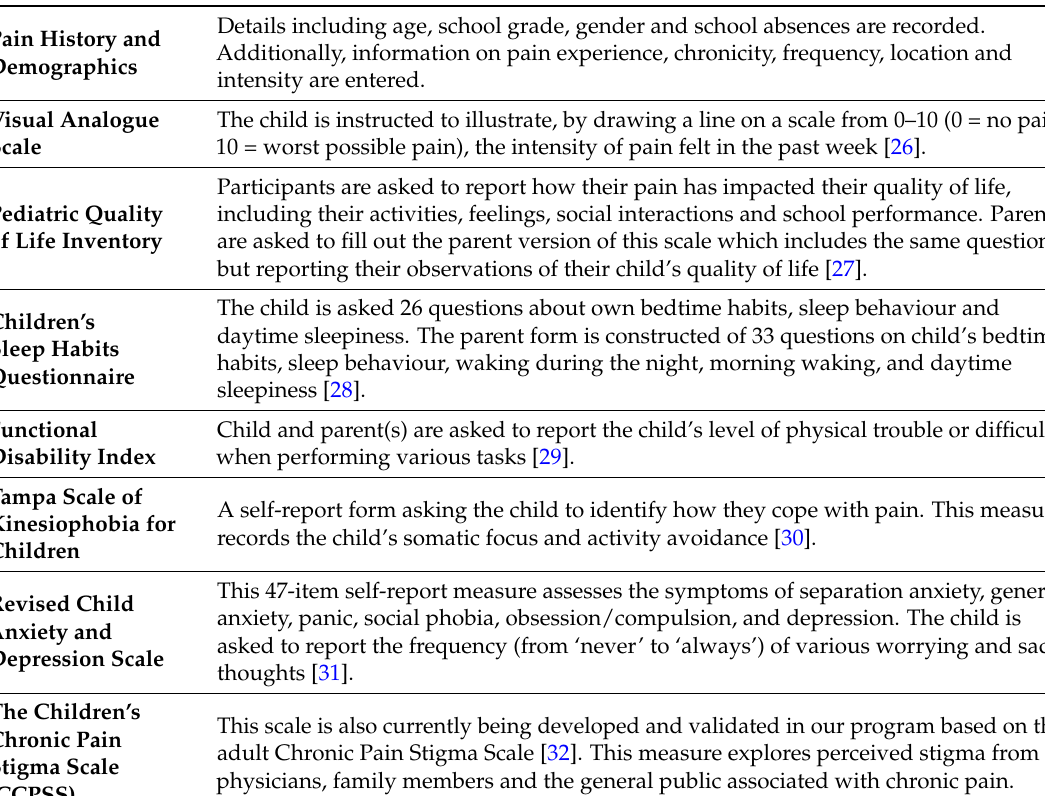
Table 2. Questionnaire measurements.